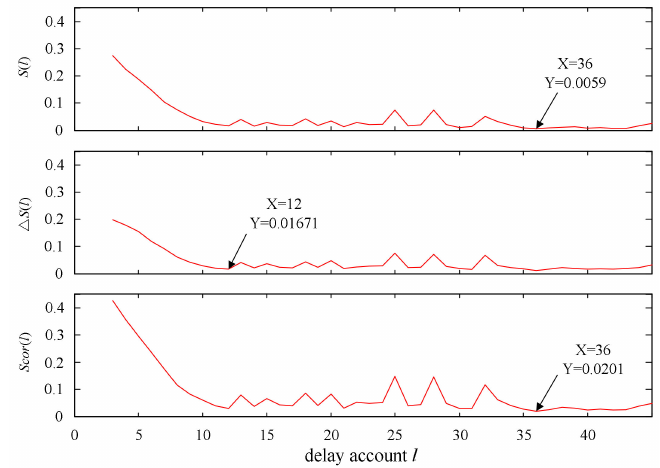
Figure 6. Statistic curves of PV power output time series using C-C methodNote: The C-C method is a kind of time delay window technique based on time